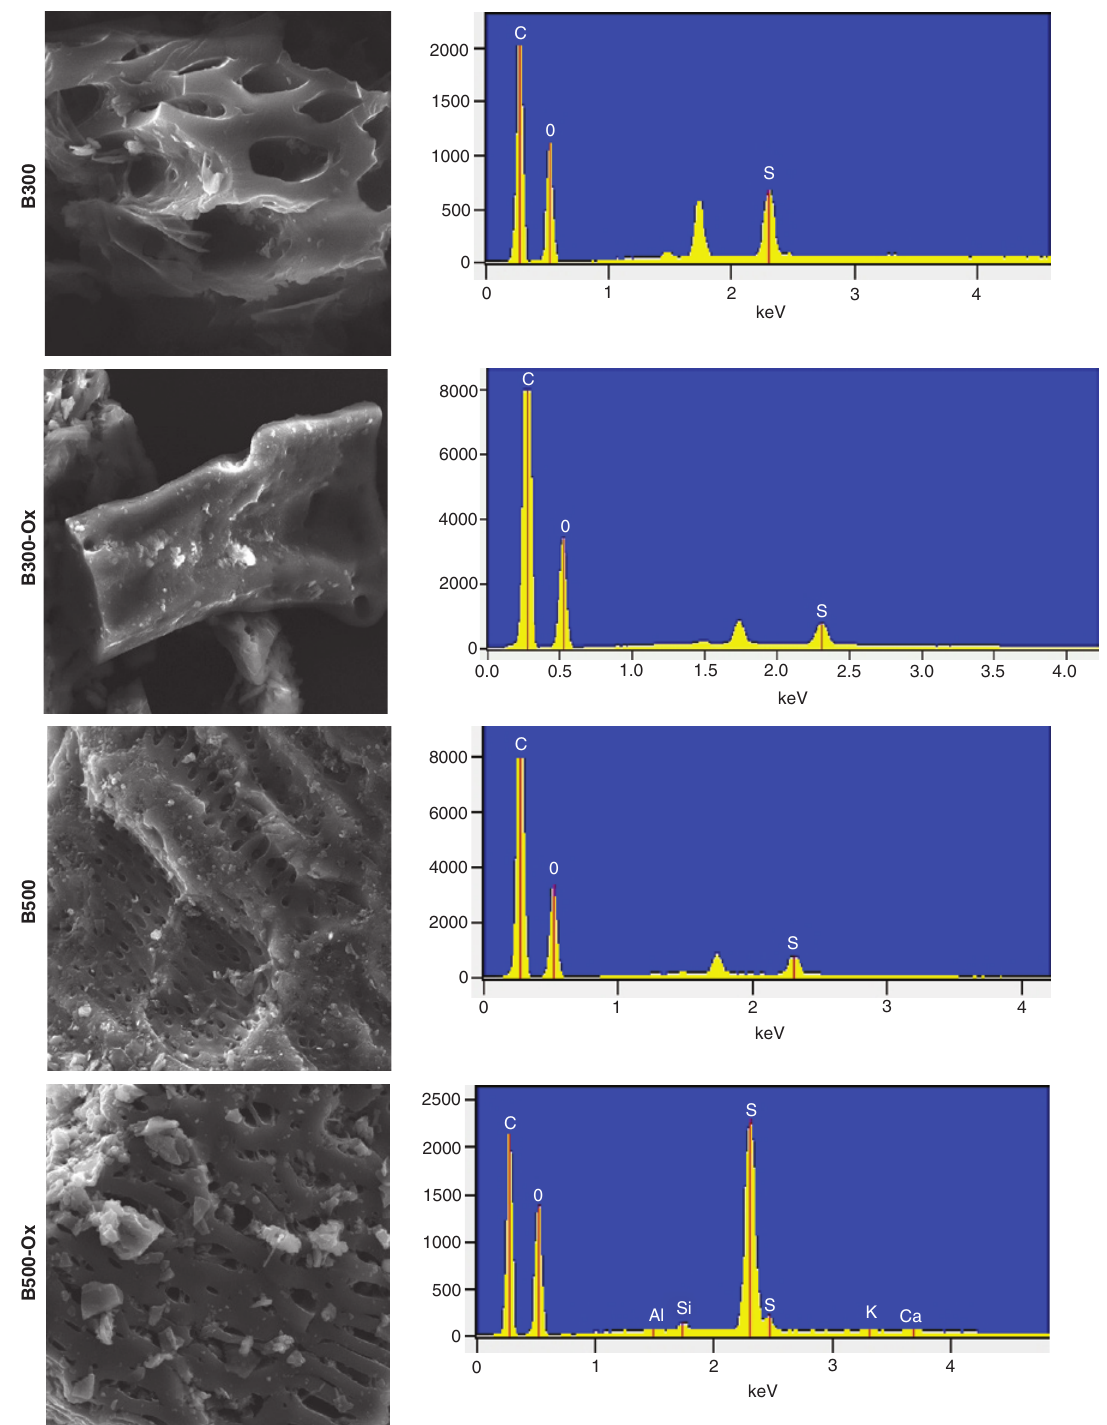
Figure 3: Scanning electron microscope (SEM) images and corresponding SEM/EDX